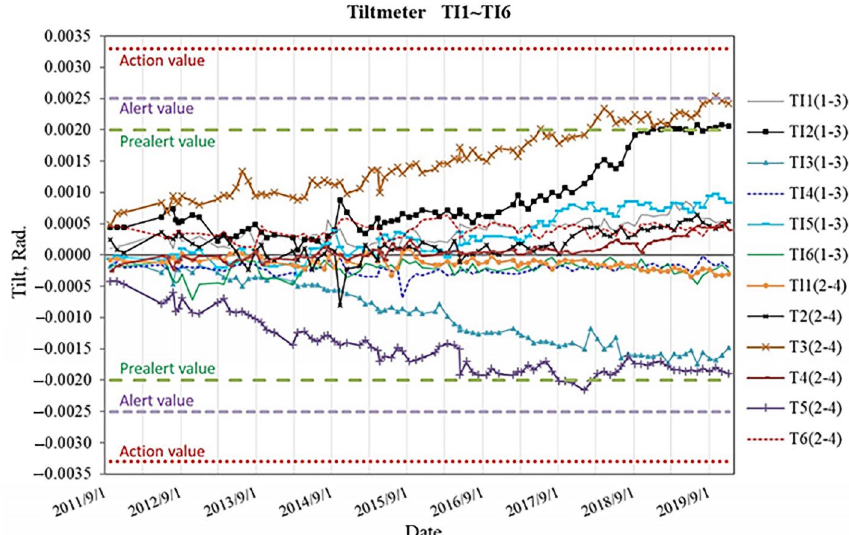
Figure 9. Monitoring results of changes in tiltmeter at the side slope of the suspension bridge with time